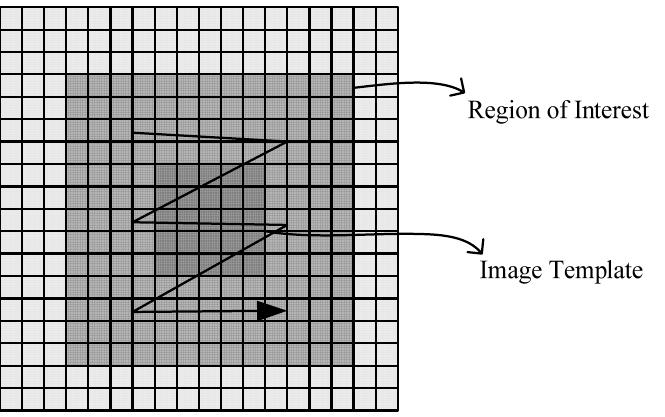
Figure 7. The template matching